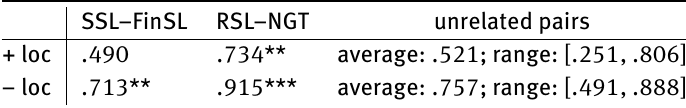
Table 4: Rank correlations ( ρ coeflcient) in related and unrelated sign language